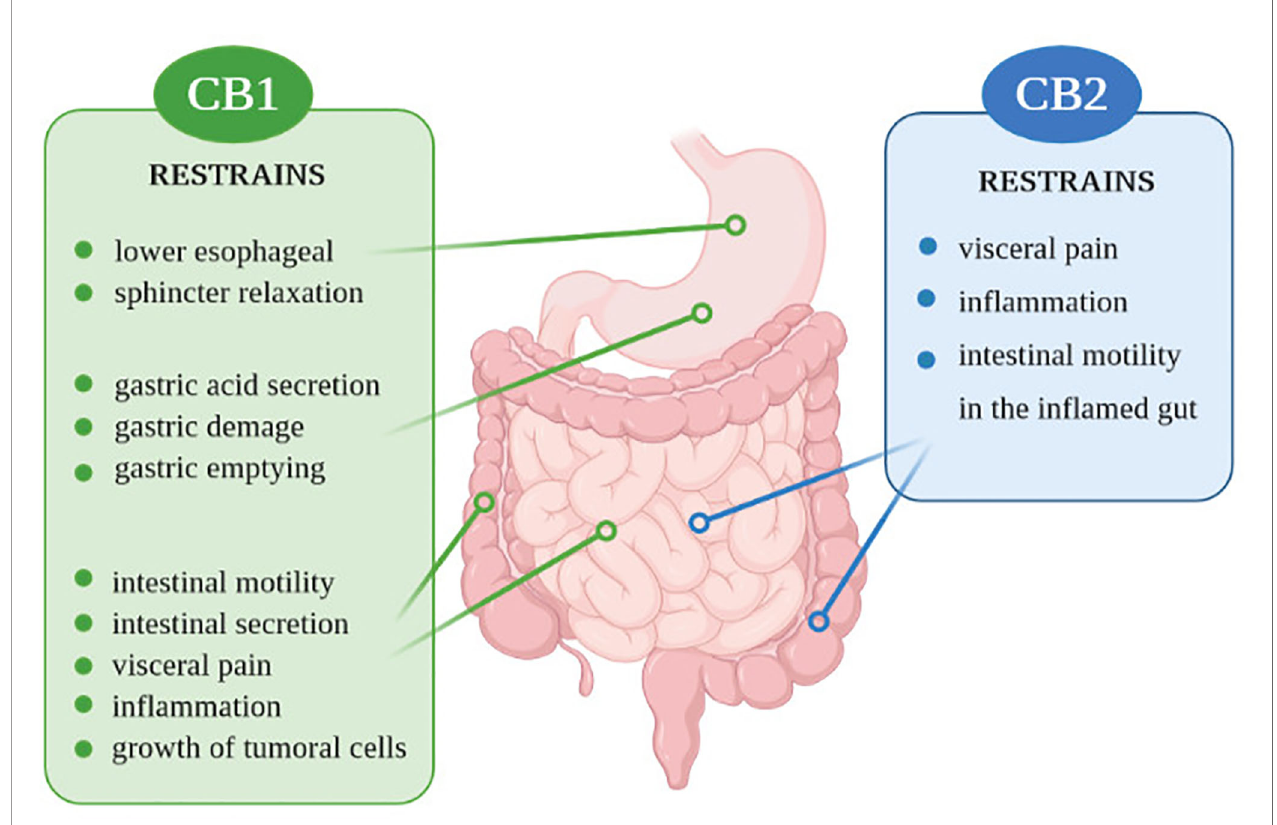
FIGURE 1 | Action of CB1 and CB2 receptors in the digestive